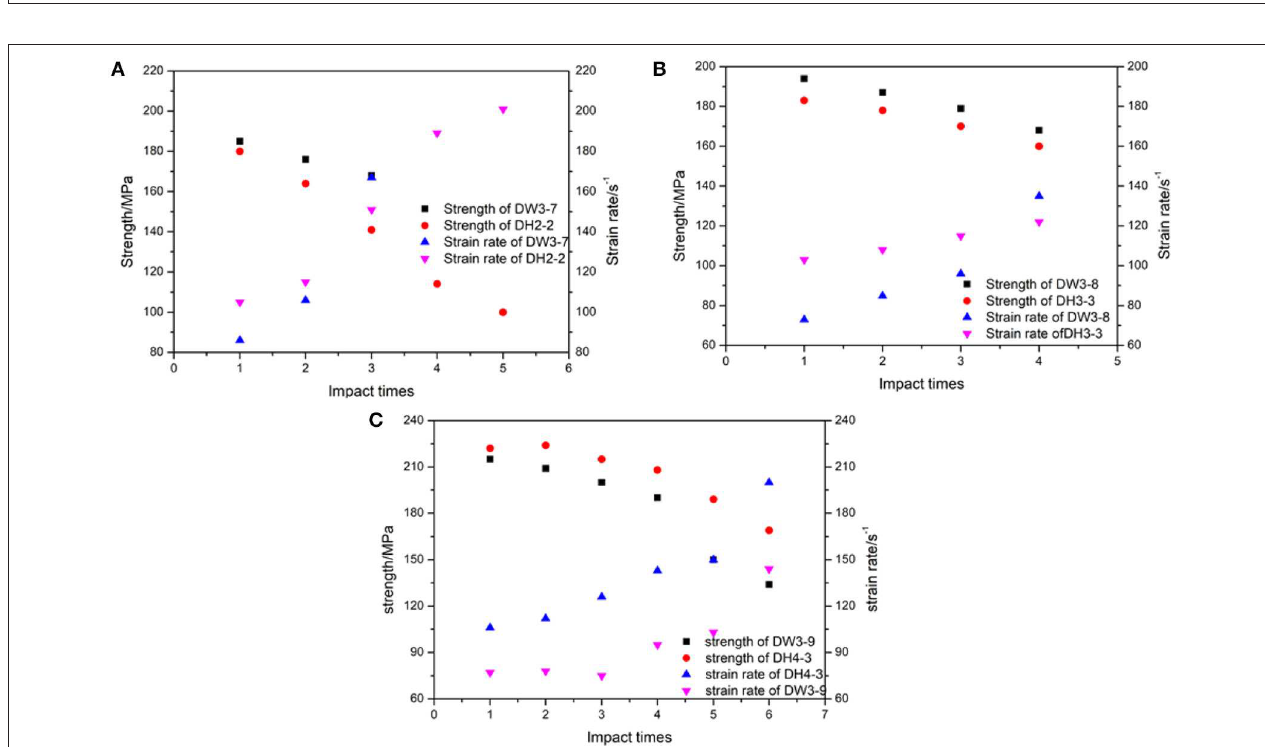
FIGURE 5 | Stress–strain curves under cyclic impact: (A) DW3-7, (B) DW3-8, (C) DW3-9, (D) DH2-2, (E) DH3-3, (F) DH4-3.